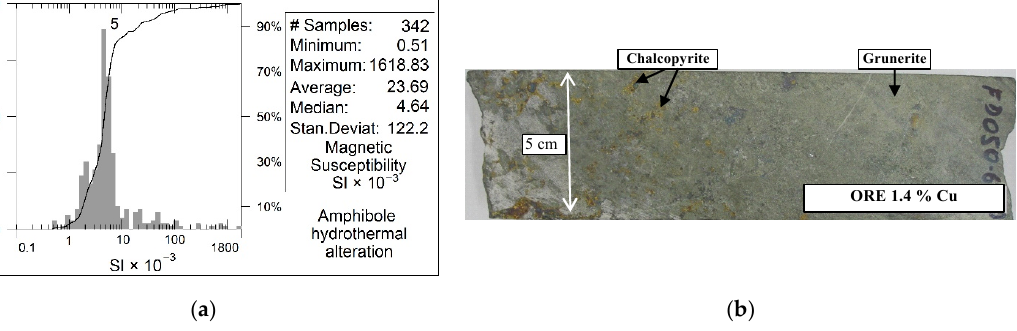
Figure A4. Amphibole (Na-Ca) hydrothermal alteration zone. ( a ) Statistics and histograms of the magnetic susceptibility measurements. ( b ) Core sample picture.